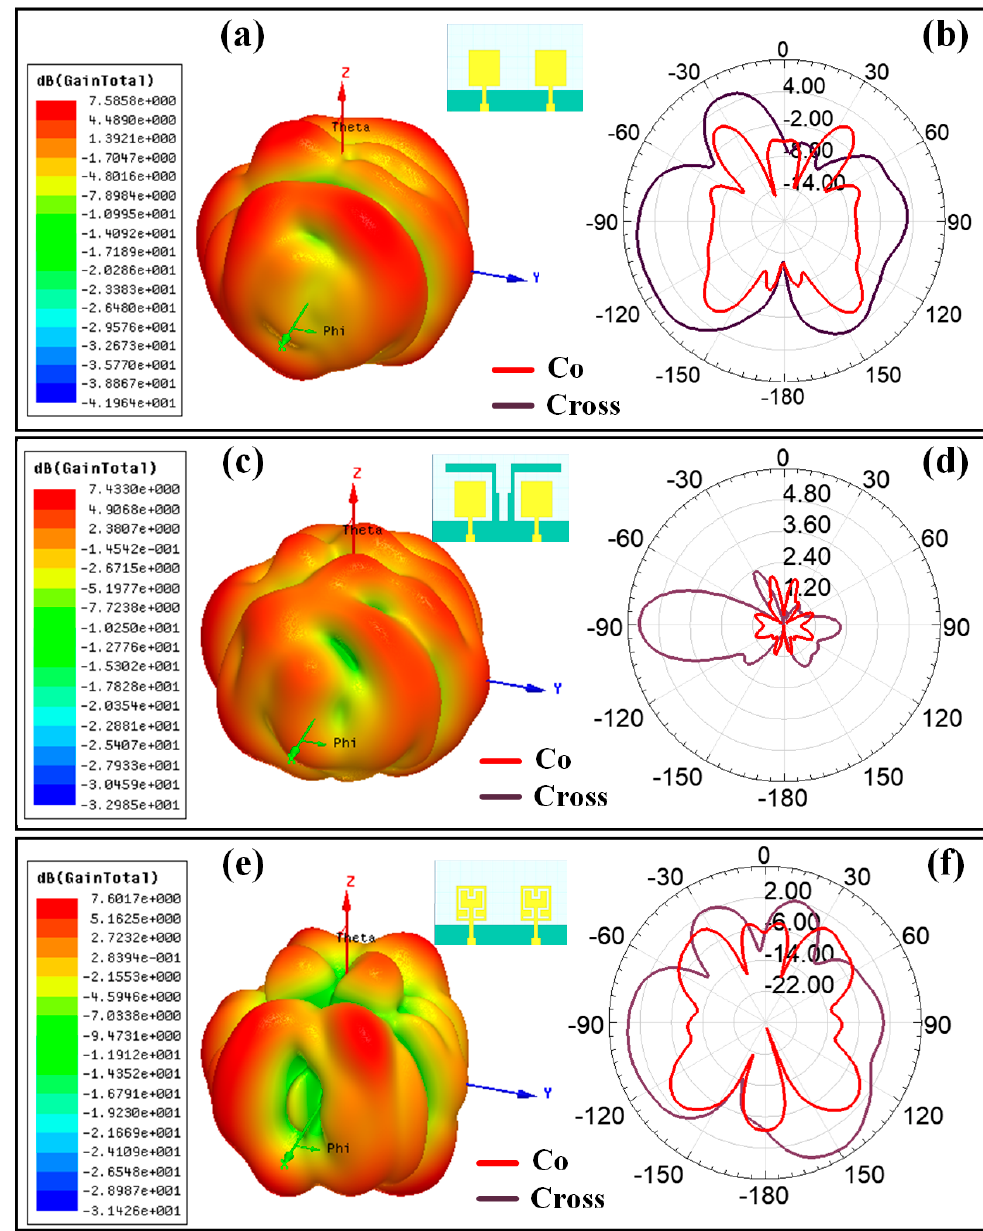
Figure 9. Polar plot for the different antenna structures (simulated results); 3D polar plot for ( a ) Design 1, ( c ) Design 2, and ( e ) Design 5. 2D polar plot for the ( b ) Design 1, ( d ) Design 2, and ( f ) Design 5 with co-polar and cross-polar response.